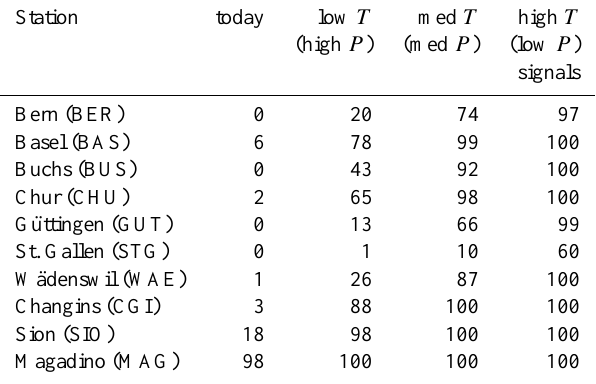
Table 2. Potential risk for 3rd generation larvae (in %) of codling moth at the various stations for today’s climate and for the three considered combinations of temperature ( T ) and precipitation ( P ) change signals described in Sect. 2.1. Station name abbreviations are given in brackets (see Fig. 1 for their